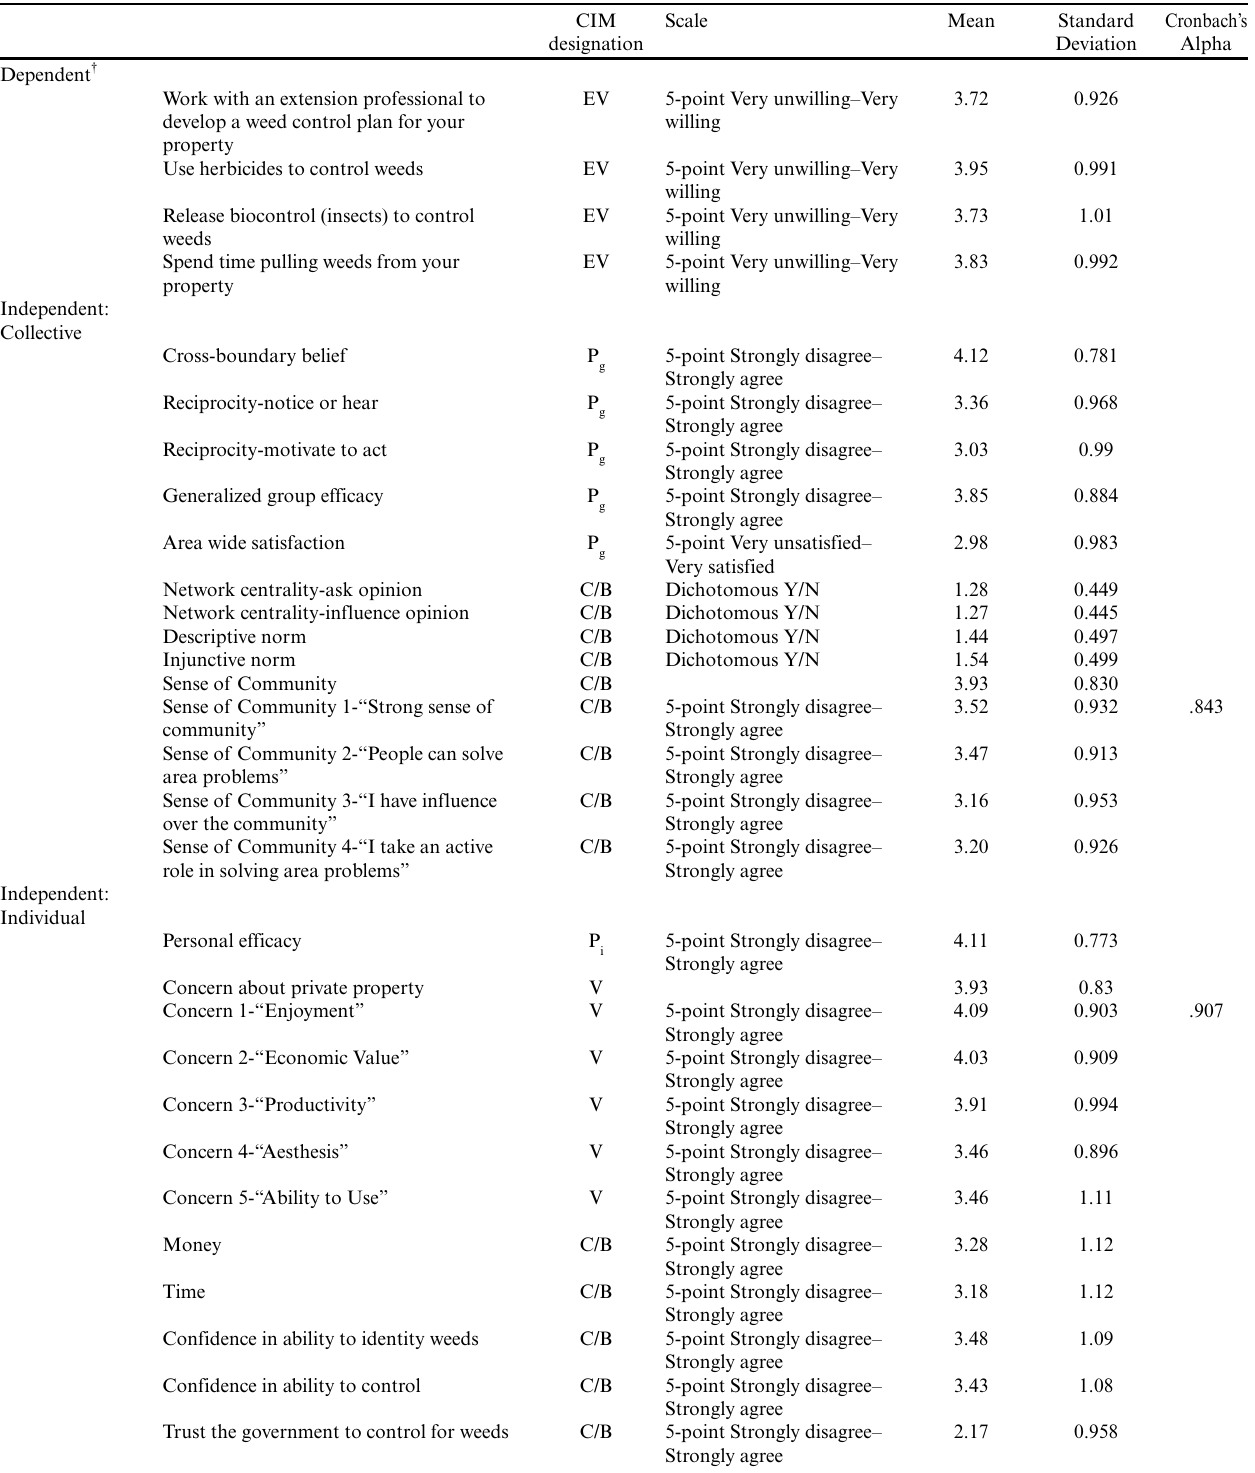
Table 1 . Constructs and descriptive statistics for the survey organized using the collective interest